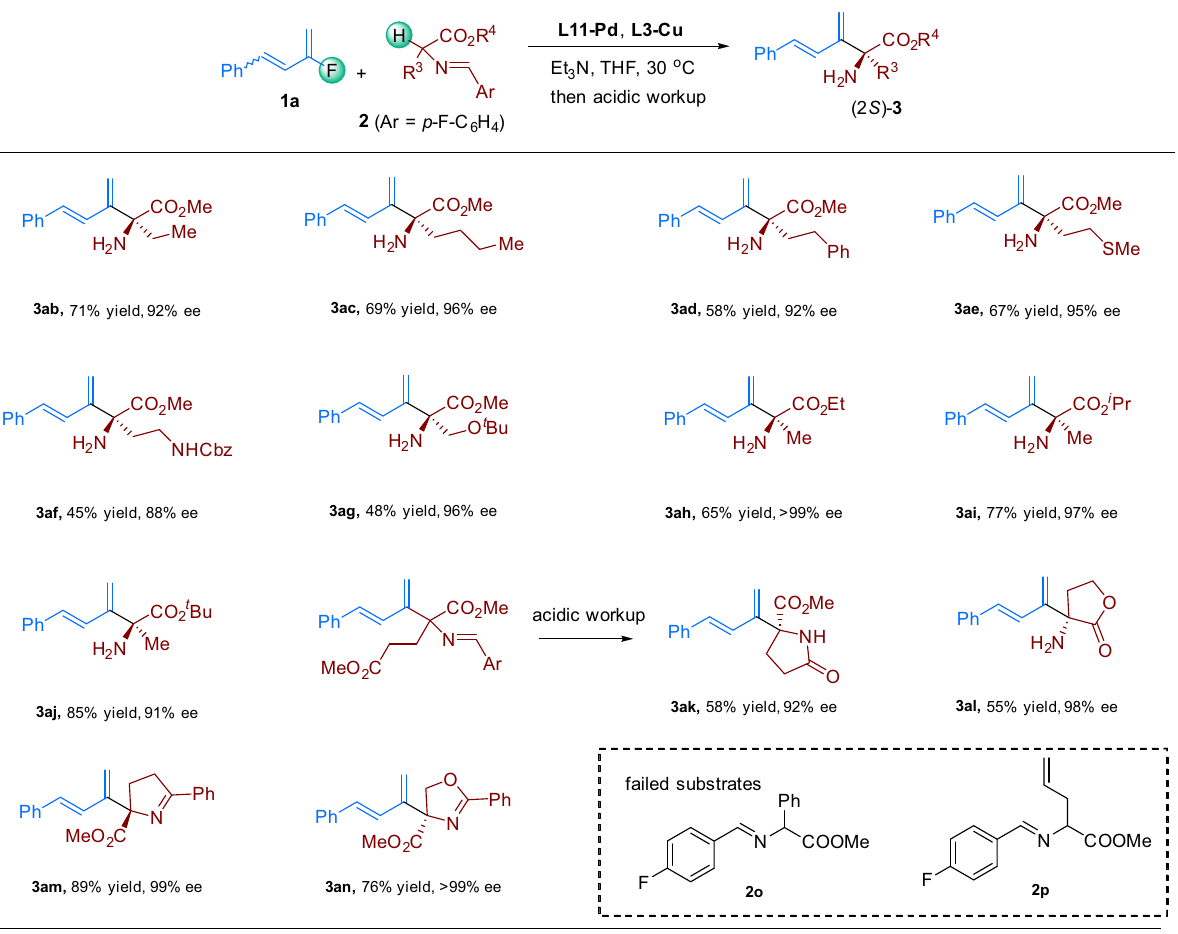
Fig. 3 Substrate scope with respect to the aldimine esters. Reaction conditions: (i) 1a (0.4 mmol), 2a (0.2 mmol), L11-Pd (4 mol%), L3-Cu (5 mol%), Et 3 N (200 mol%), THF (0.5 mL), 30 °C, 48 h; (ii) citric acid (10 wt%, 4 mL). Isolated yields are provided. The ee values were determined by HPLC on a column with a chiral stationary phase.